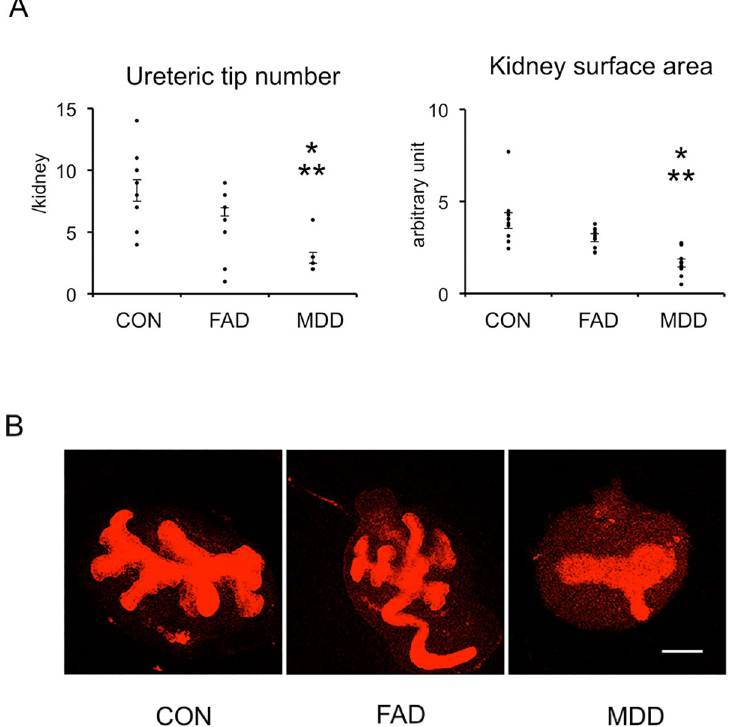
Fig 6. Effect of folic acid deficient- and methyl donor-deficient medium in organ culture. Embryonic day 13 metanephroi from normal rats were subjected to organ culture in DMEM (CON), DMEM deficient in FA (FAD), or DMEM deficient in FA, choline, and methionine (MDD) for 3 days. Ureteric buds were visualized by whole mount staining with anti-pancytokeratin antibody. ( A) Quantitative analysis. n = 3 litters, n = 10–11 kidneys. Statistical analysis was performed with ANOVA followed by Tukey’s test. Bars represent ± SE. � , P < 0.05 vs CON; �� , P < 0.05 vs FAD. ( B) Representative images. Scale bar, 250 μ m.